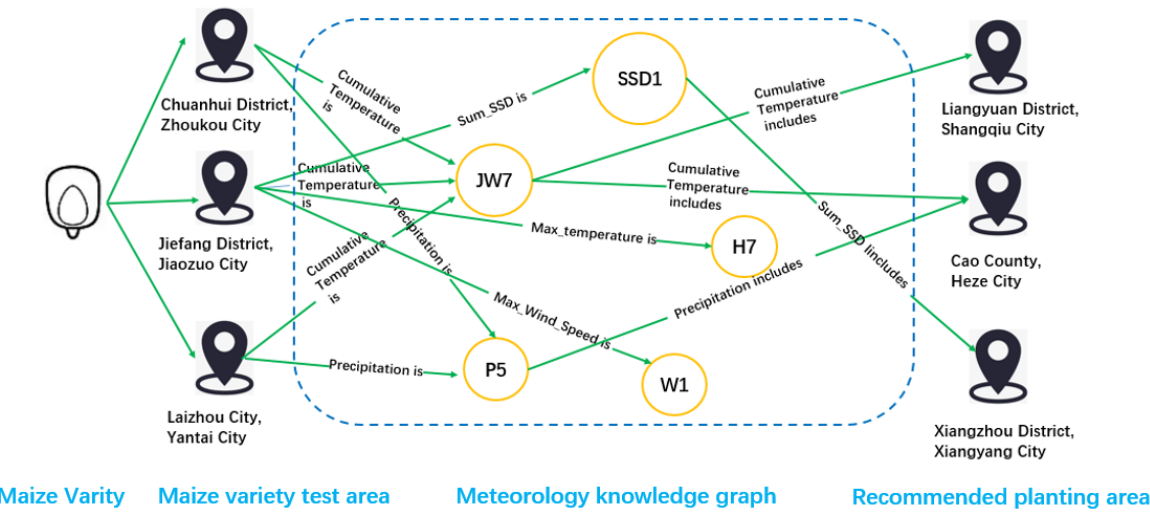
Figure 4. Example of precise recommendation process for suitable planting area of maize varieties enhanced by knowledge graph.